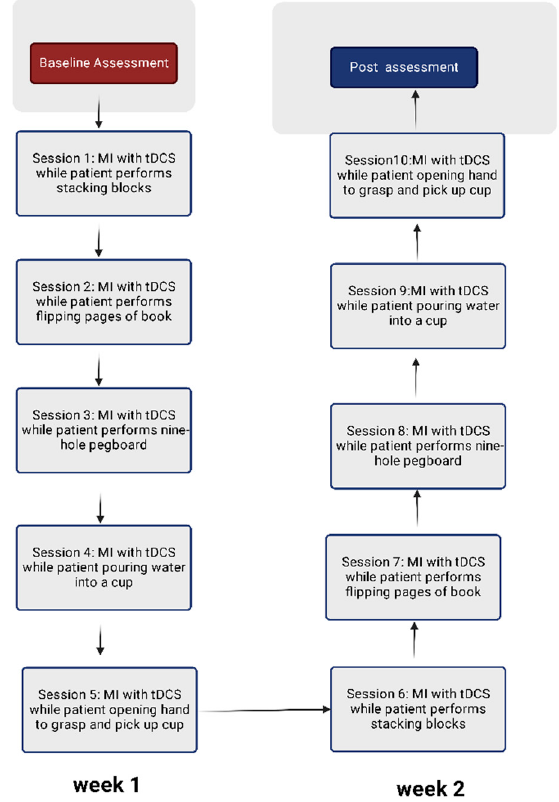
Figure 3. Regime of 10 sessions of treatment for two weeks.